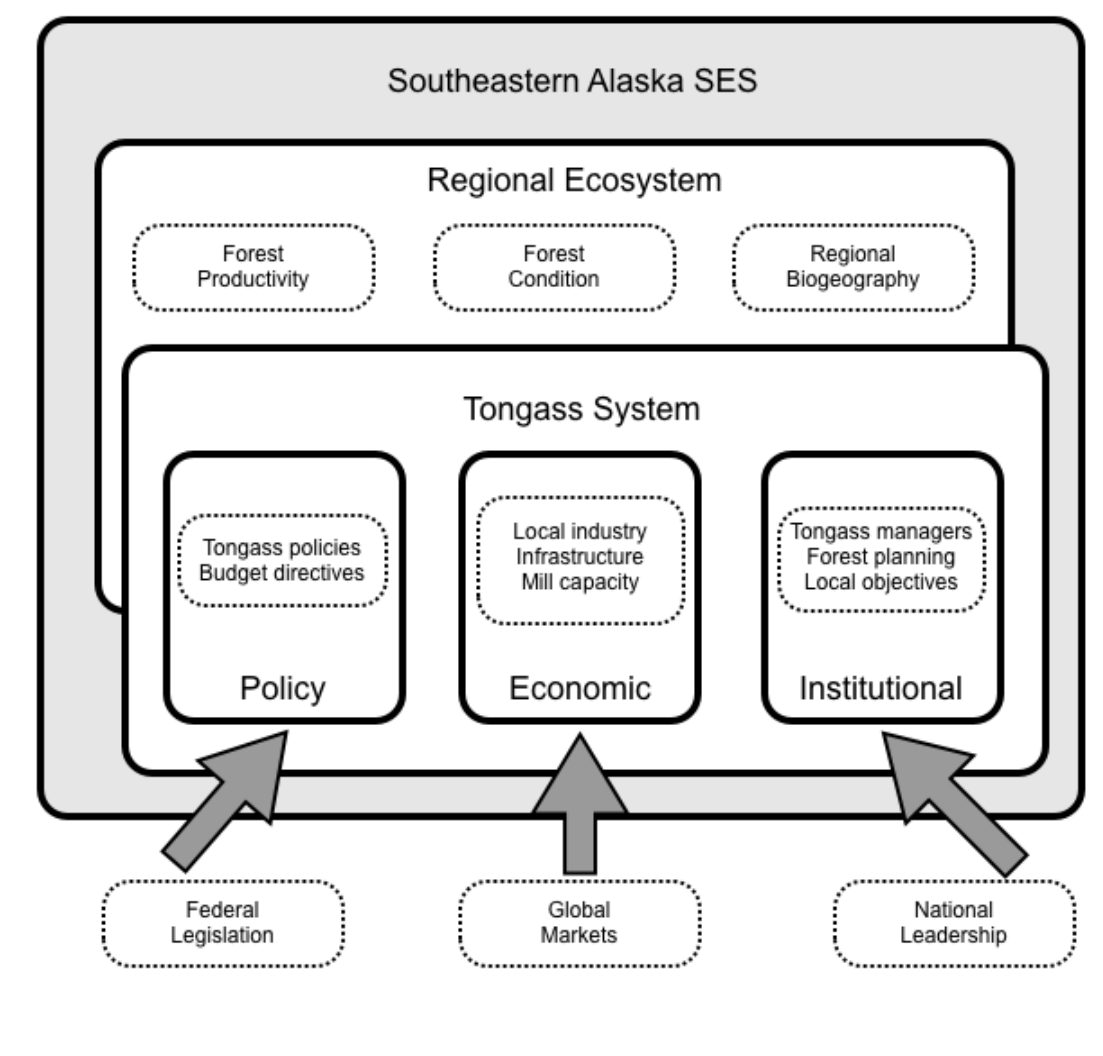
Fig. 1. Conceptual diagram of the southeastern Alaska social–ecological system (SES), with an emphasis on the Tongass system, including components and drivers of change of interest in the case